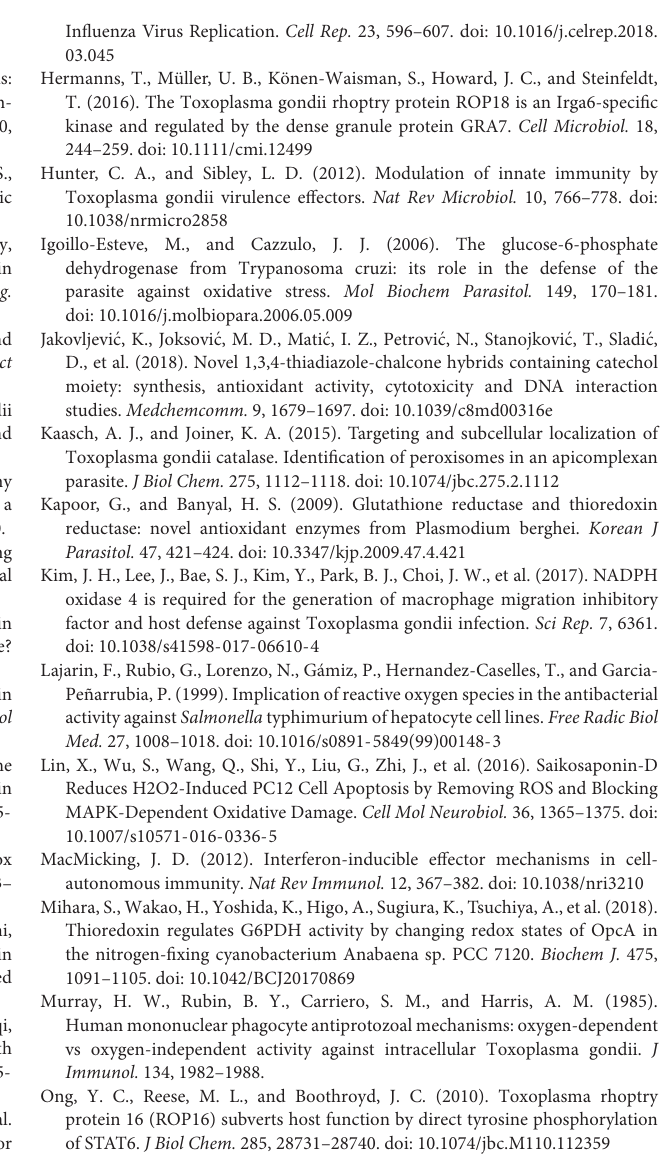
Supplementary Figure 1 | PCR validation of CAT- and hypothetical protein (HP)-KO parasites. Supplementary Figure 2 | Bioinformatics analysis of hypothetical protein HP1. Supplementary Table 1 | Primers used in this study. Supplementary Table 2 | Information on the 30 genes selected in the analyses. Supplementary Data Sheet 1 | Raw sgRNA read counts and analysis of sgRNA sequencing